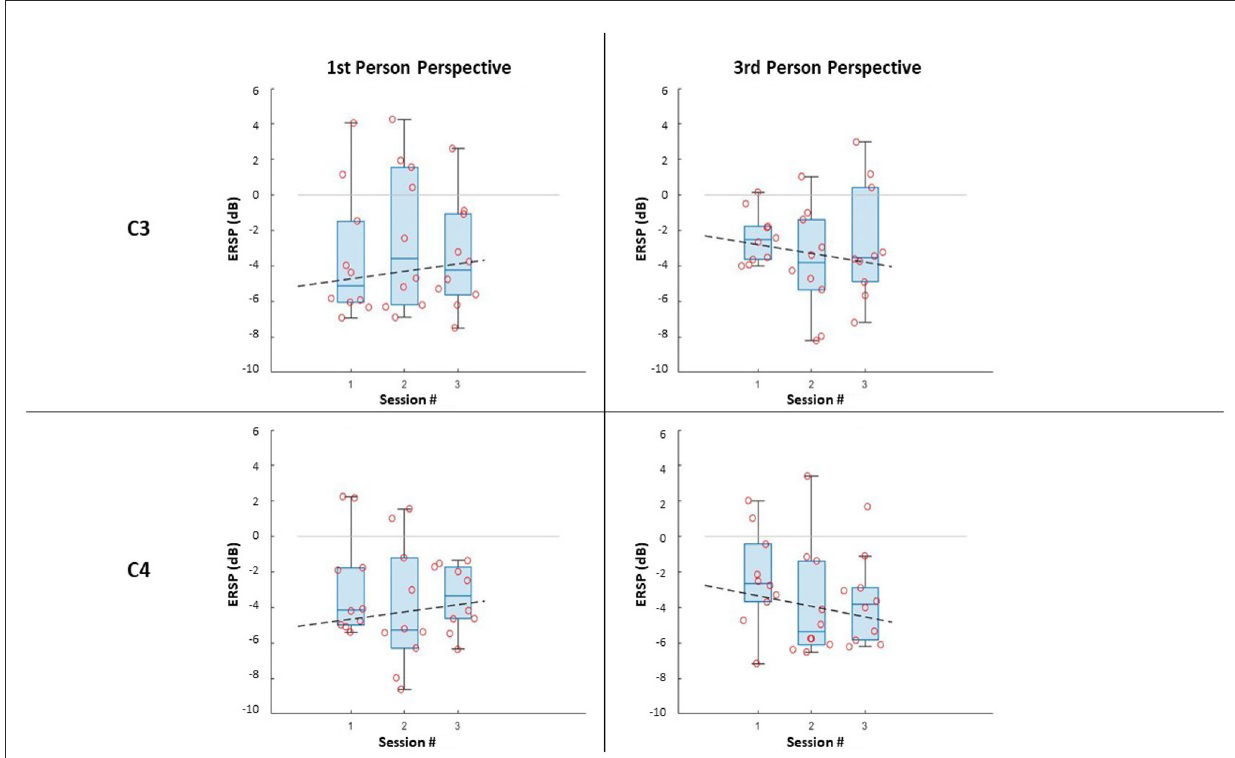
FIGURE4 ERSP distributions along sessions for MI left-hand trials: ERSP recorded in channel C3 and C4 in the first-person and third-person perspectives. The dashed lines represent the interpolation of the medians of each session.